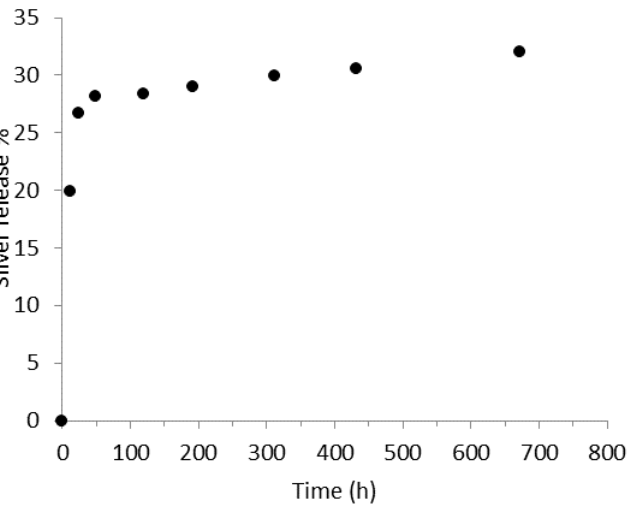
Figure 9. Silver release profile of PLA/PEO AgNPs (4.0 wt.%) in 25 mM PBS (pH = 7.2) at 37 °C.